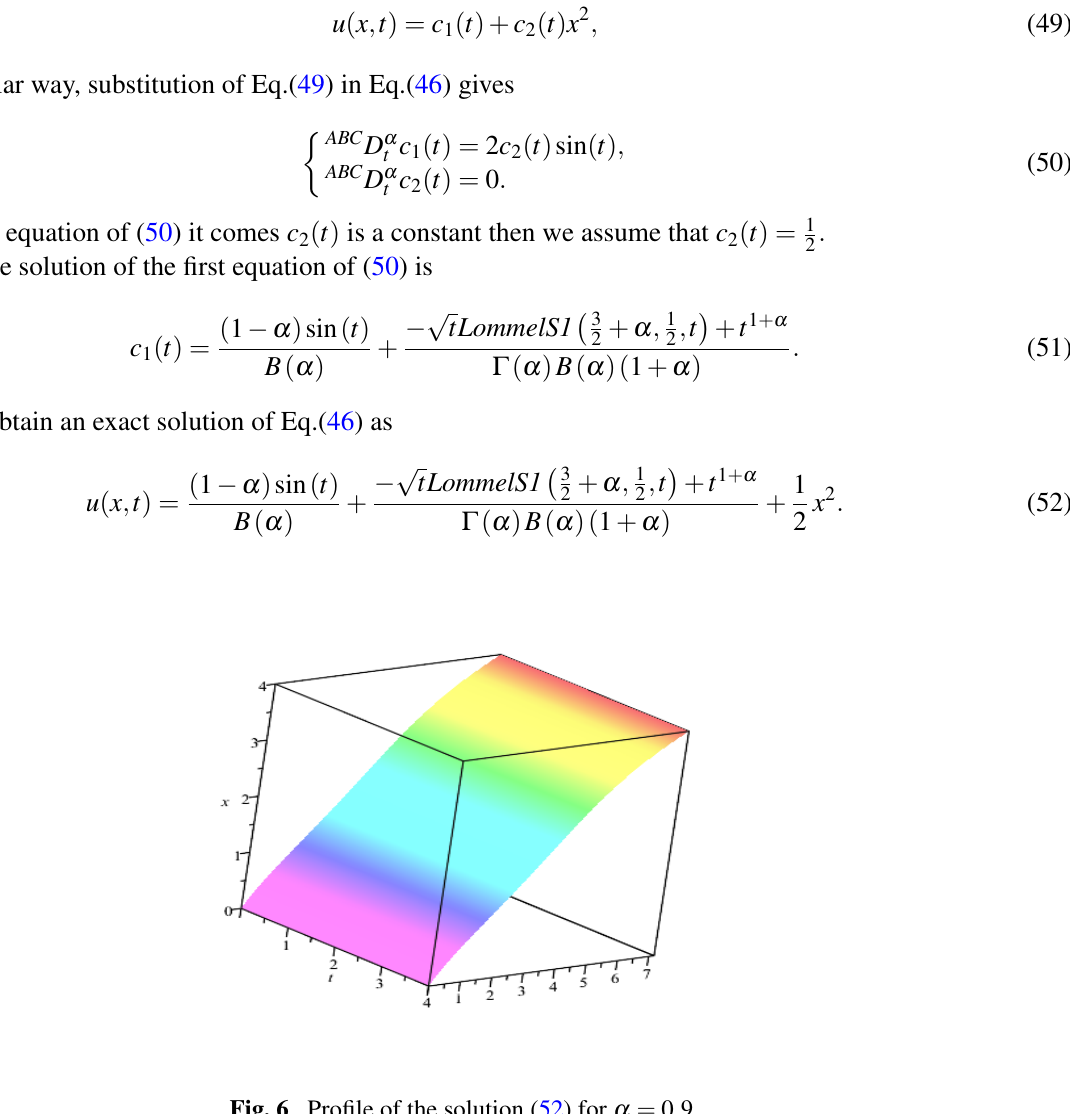
Fig. 6 Profile of the solution (52) for α = 0 . 9